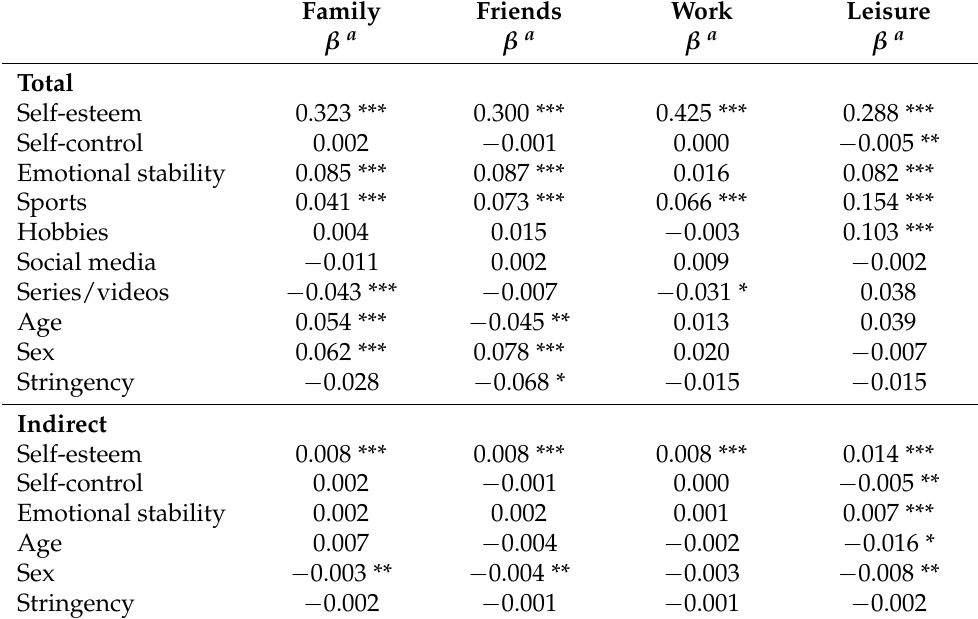
Table 5. Total and indirect effects on